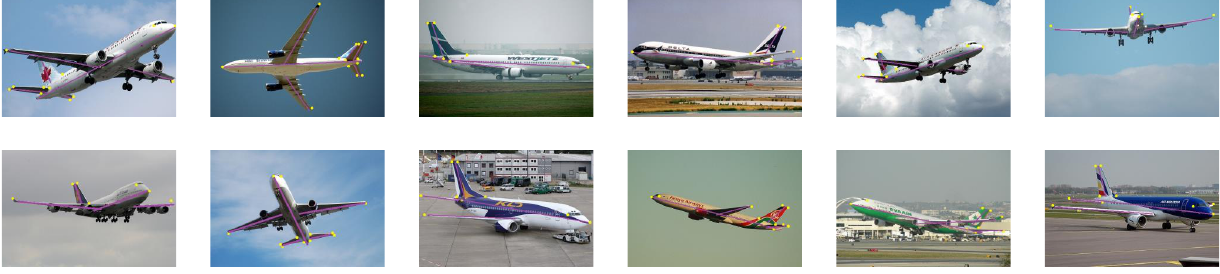
Figure 14. Qualitative results for the proposed method on ObjectNet3D dataset. The yellow points are the keypoints and the purple segments are the